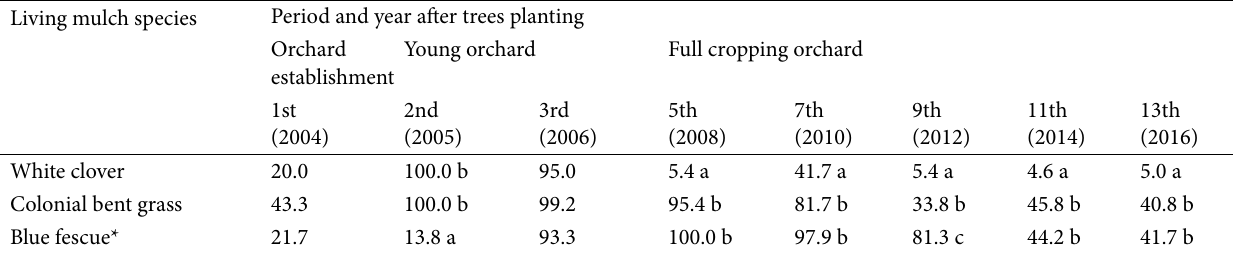
Table 2 Change in the mean percentage of the soil surface under the three living mulch sod cover in the tree rows, in the succeeding years 2004 −